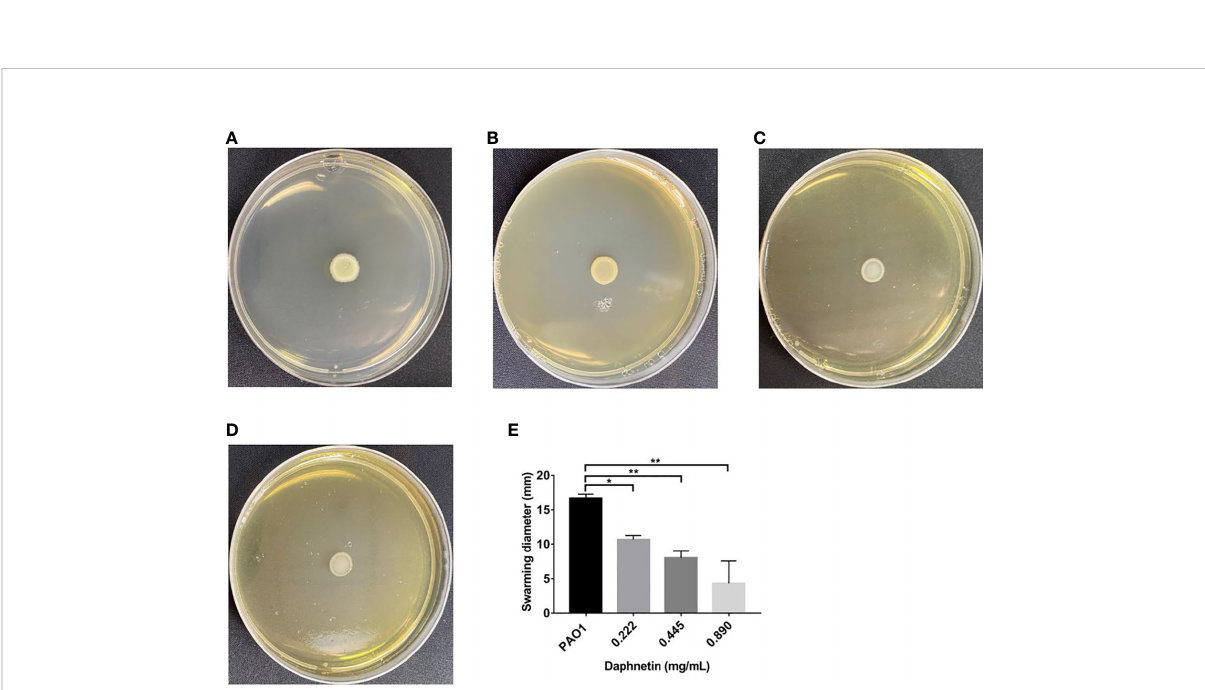
FIGURE 9 Effect of daphnetin (DAP) on swarming motility of P. aeruginosa . Swarming motility assay was conducted on plates containing different concentrations of DAP and in the absence of DAP (Untreated Control). (A) PAO1 group. (B) DAP group with fi nal concentration of 0.222 (mg/mL). (C) DAP group with fi nal concentration of 0.445 (mg/mL). (D) DAP group with fi nal concentration of 0.890 (mg/mL). (E) Swarming diameter of each group. Results are represented as the mean ± SD; ** and * indicate P-values < 0.01 and < 0.05, respectively. ANOVA was used to compare the groups (600×600